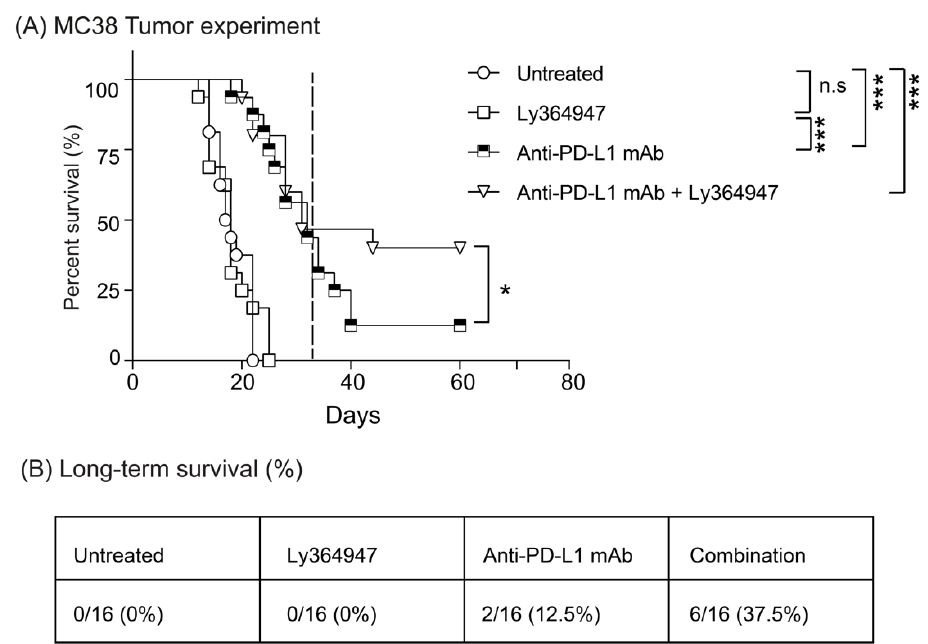
Figure 2. LY364947 improves anti-PDL1 mAb therapy. ( A ) MC38 tumor-bearing mice were treated with 200 µ g anti-PDL1 mAb i.p. (MIH5; days 8, 10, and 13) and / or 10 mg / kg TGF- β receptor kinase inhibitor i.p. (LY364947; days 8, 10, 13, and every three days). Data presented as Kaplan–Meier survival curves with a total of 16 animals per group. Dashed line represents day 31. The log-rank test was used to determine the statistical significance of the survival. ( B ) Percentage of mice bearing subcutaneous MC38 treated with indicated regimens that rejected the tumor and survived tumor-free-long-term. Data compiled from two independent experiments, 16 mice per group. PDL1: programmed death-ligand 1. (* p < 0.05; *** p < 0.001, n.s, non signifiant).